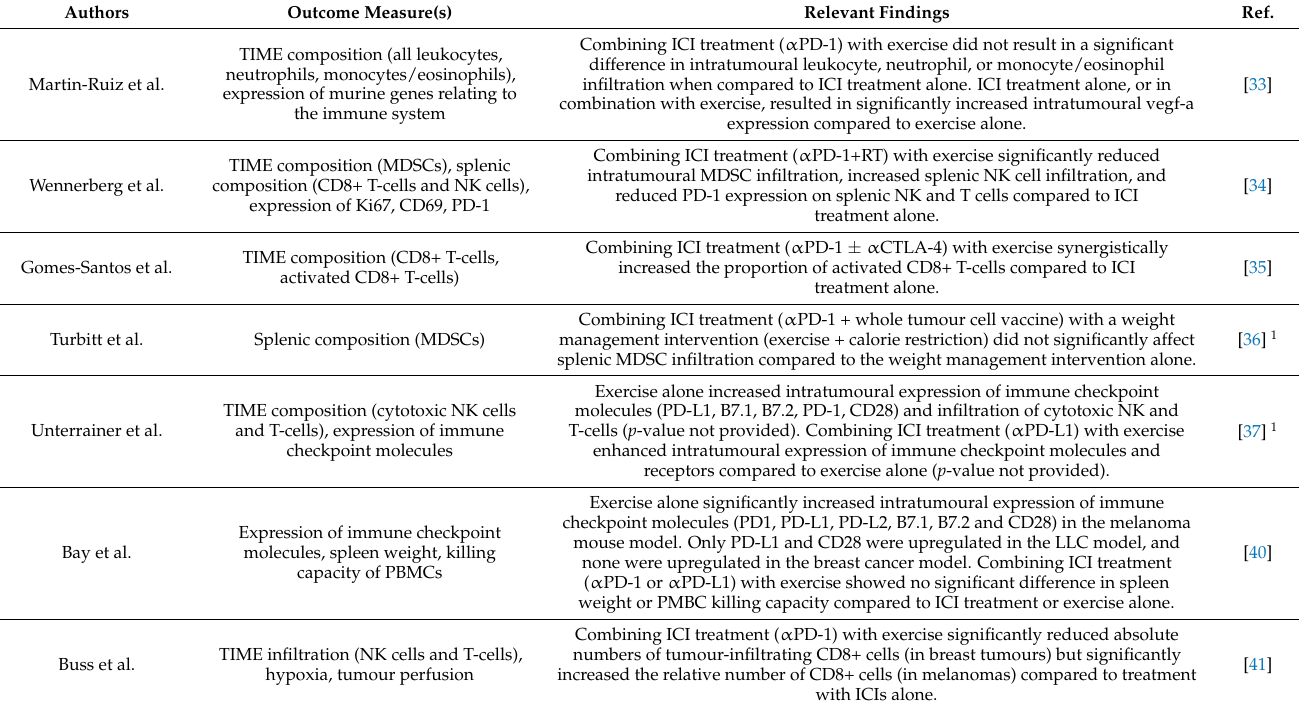
Table 5. Findings from studies addressing biological mechanisms (n =